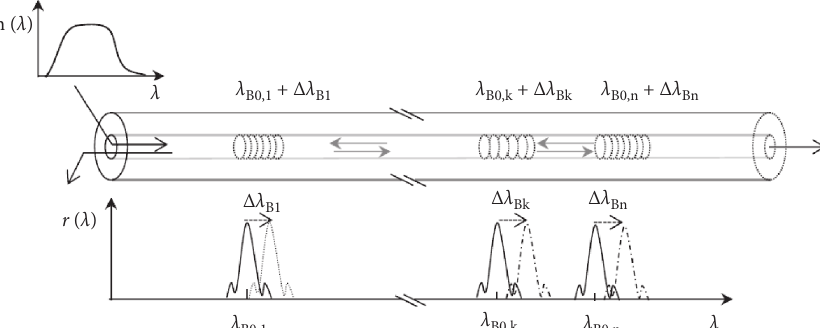
Figure 2: Schematic diagram of wavelength-division multiplexing technology of FBG.